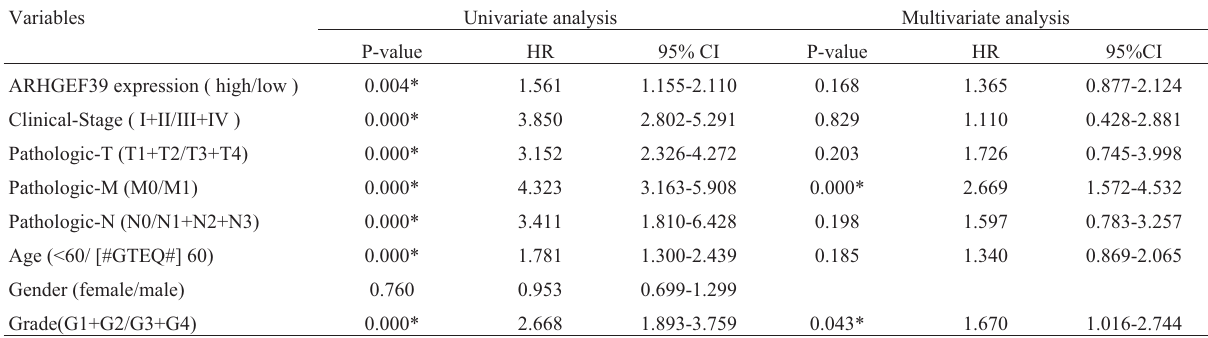
Table 2 - COX proportional hazards regression analyse for the survival analysis of ccRCC patients from TCGA database.